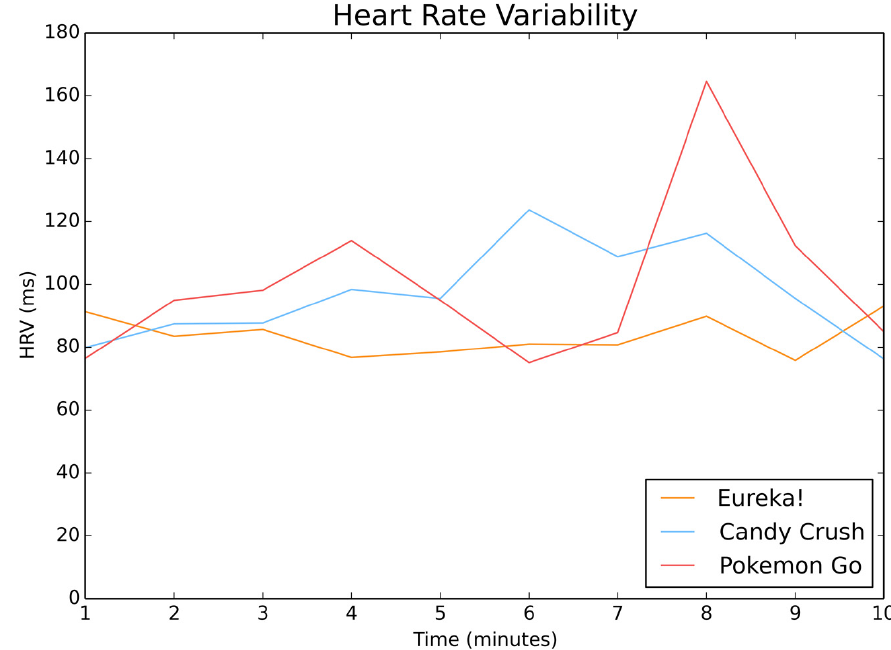
Figure 6. Relation of three games with the HRV.